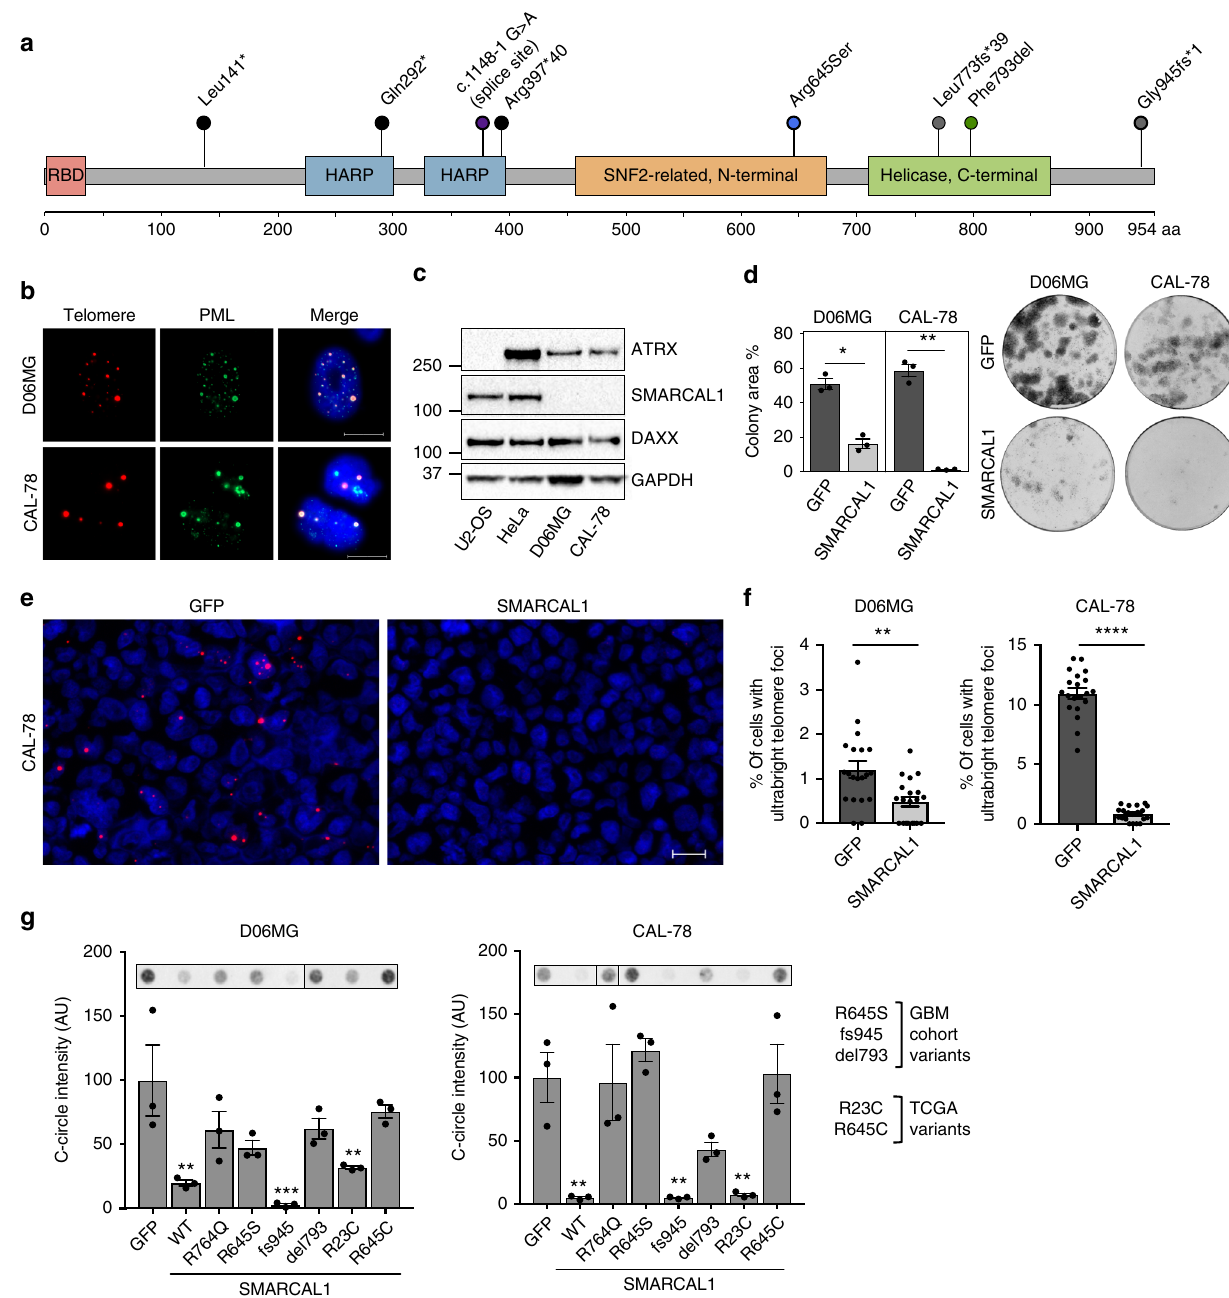
Fig. 4 Inactivating mutations in SMARCAL1 mutations cause hallmarks of ALT. a The majority of mutations identi fi ed in SMARCAL1 in an expanded cohort ( N = 39) of TERTp WT -IDH WT GBMs are likely inactivating (frameshift, nonsense). Protein domains of SMARCAL1 are shown (RBD RPA-binding domain, HARP HepA-related protein). b We identi fi ed two cancer cell lines harboring inactivating mutations in SMARCAL1 : D06MG (patient-derived GBM, W479X) and CAL-78 (chondrosarcoma, deletion of exons 1 – 4). These cell lines exhibit signs of ALT, including ALT-associated PML bodies (APBs), as indicated by the co-localization of PML (immuno fl uorescence) and ultrabright telomere foci (FISH), and the accumulation of C-circles. c Western blot con fi rms the absence of SMARCAL1 expression in both CAL-78 and D06MG, as well as intact expression of ATRX and DAXX . Controls include U2-OS ( ATRX -negative) and HeLa (positive control). d Overexpression of SMARCAL1 signi fi cantly decreased (D06MG, P < 0.05; CAL-78, P < 0.005) colony- forming ability as measured by percent area. e , f Overexpression of SMARCAL1 dramatically reduces the appearance of ALT-associated ultrabright telomere foci relative to the GFP control (CAL-78 is shown). g SMARCAL1 constructs harboring either wildtype, helicase dead (R764Q, from SIOD), mutations from the expanded cohort (R645S, del793, fs945) and recurrent mutations seen in pan-cancer data (R23C, R645C) were assayed for effects on ALT-associated C-circles. The SMARCAL1 helicase domain function is critical for suppression of C-circles, as constructs with mutations in these domains fail to fully suppress markers of ALT, compared to wildtype constructs or SMARCAL1 with mutations in the RPA-binding domain (R23C) or the 945 fs variant. Error bars in d , f , g denote s.e.m. * P < 0.05; ** P < 0.01; *** P < 0.001; **** P < 0.0001; Paired t -test ( d , f ) and one-way ANOVA with Dunnett ’ s multiple comparisons test ( g ). Scale bar indicates 20 μ m. Colony formation and C-circle experiments were performed in